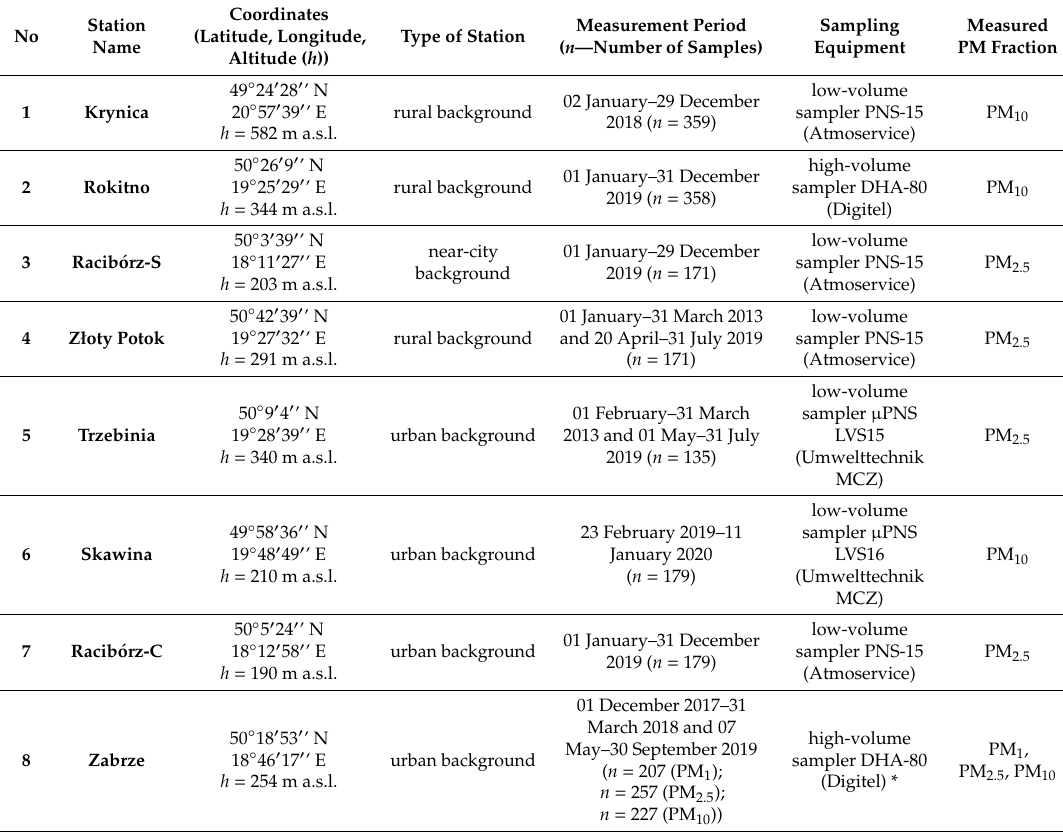
Table 1. General information about measurement campaigns selected for